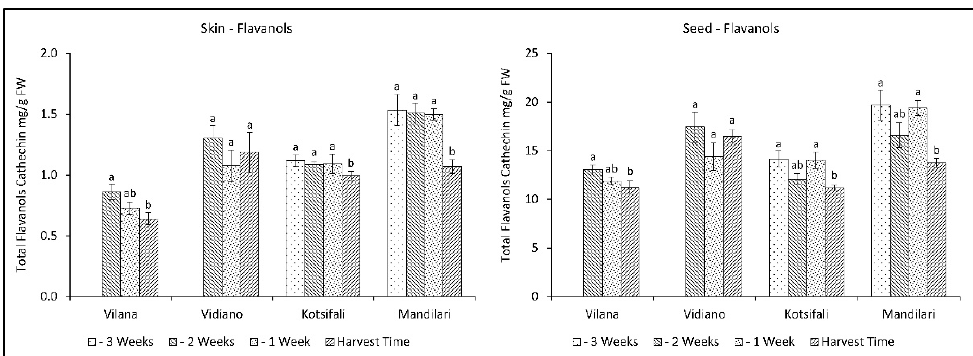
Figure 5. Skin and seed total flavanols content (mg CE g −1 FW) of Vilana, Vidiano, Kotsifali and Mandilari cultivars during ripening. The error bars represent the standard errors of the means. Different letters indicate statistically significant differences among weeks, according to Duncan’s multiple range test ( p ≤ 0.05).